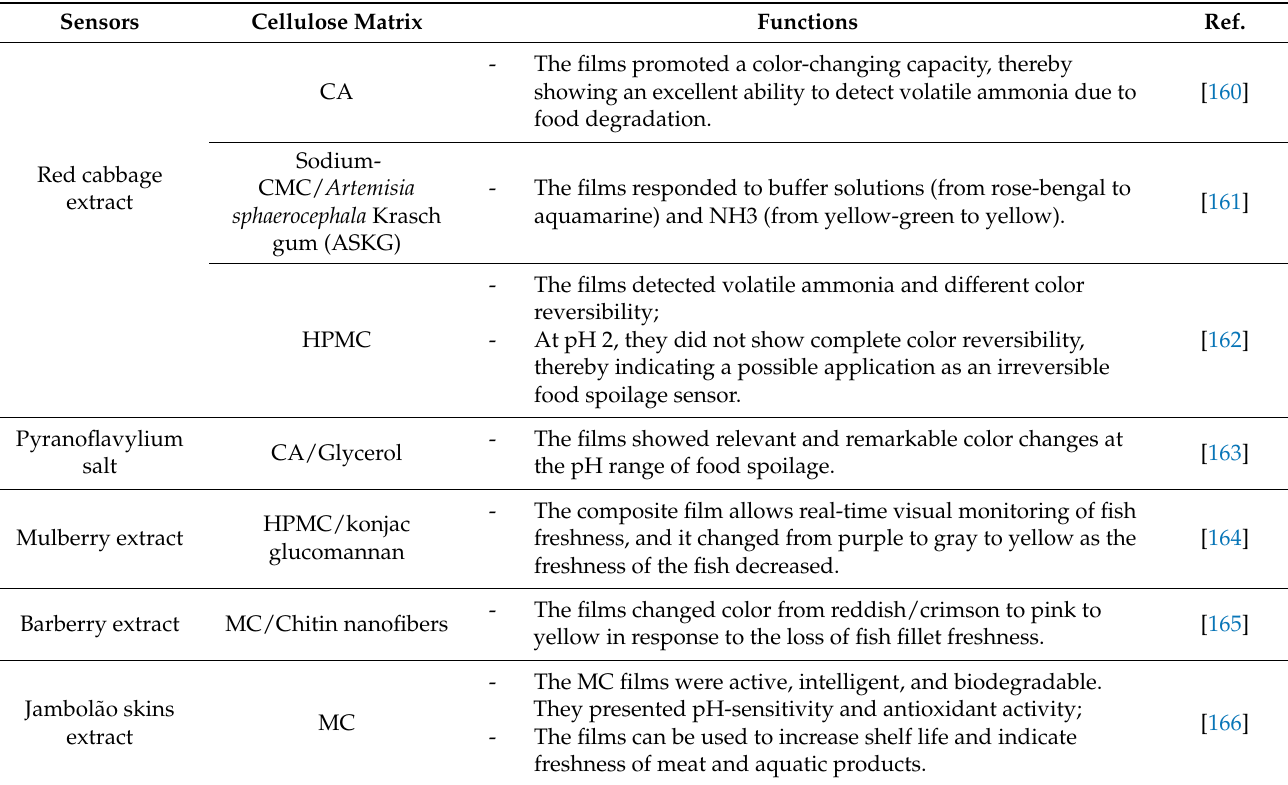
Table 3. Summary of pH-sensitive cellulose